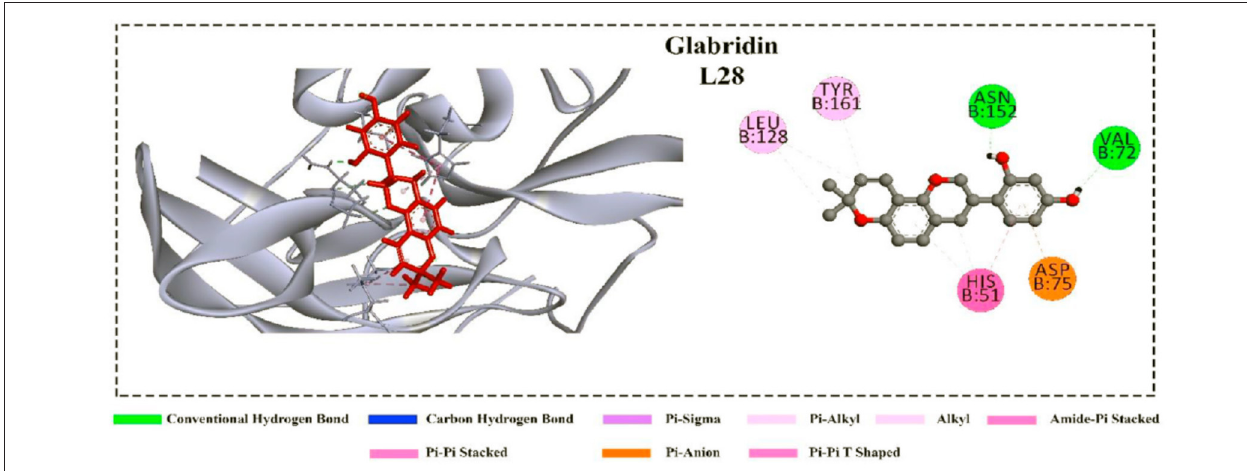
FIGURE 5 | Non-covalent interactions of the glabridin with the NS3 protease (87).